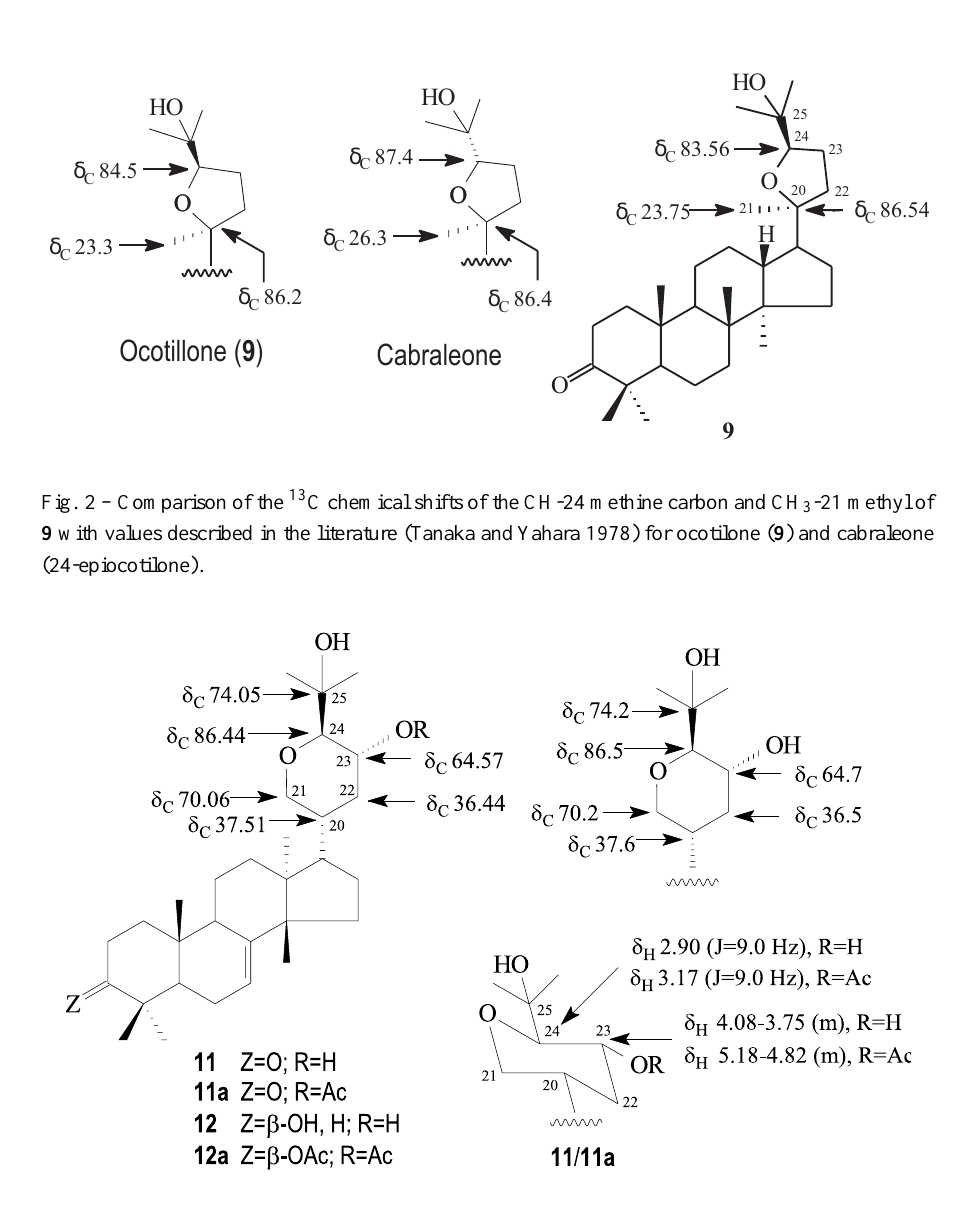
Fig. 3 – Comparison of the chemical shifts of C-20 to C-25 of 11 with the corresponding values of sapelin A (Z= α -OH,H; R=H) reported in the literature (Jolad et al. 1981. The coupling constant ( J = 9 . 0 Hz) observed for signals of 11 and 11a reveal an axial-axial interaction between H-24 and